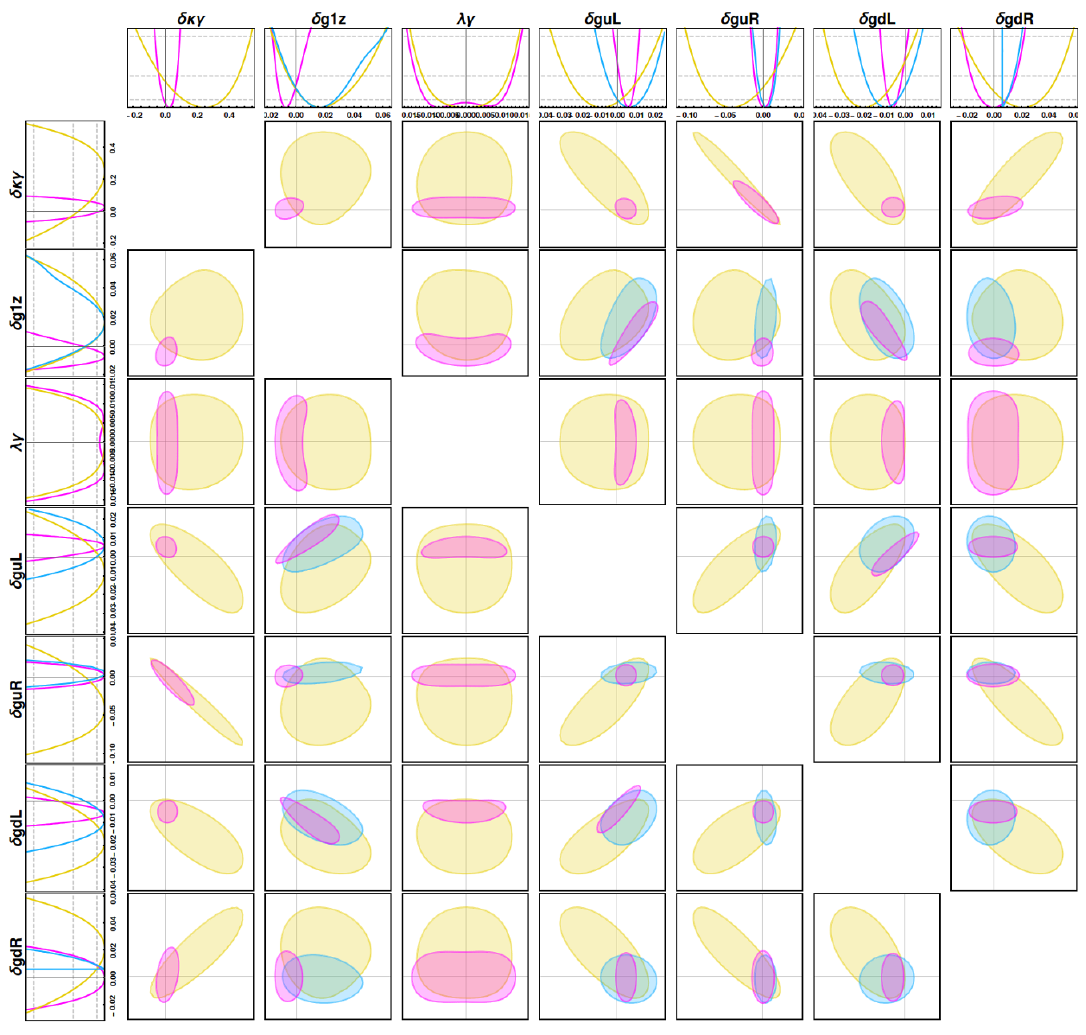
Figure 12 . One and two dimensional 95% CL constraints for the seven parameters entering in diboson processes, using only the current LHC data in table 1. In yellow, all parameters are pro(cid:12)led. In blue, we pro(cid:12)le over all parameters but setting (cid:14)(cid:20) (cid:13) = (cid:21) (cid:13) = 0. In pink, we do an exclusive (cid:12)t setting to zero all parameters that do not appear in the plot labels.